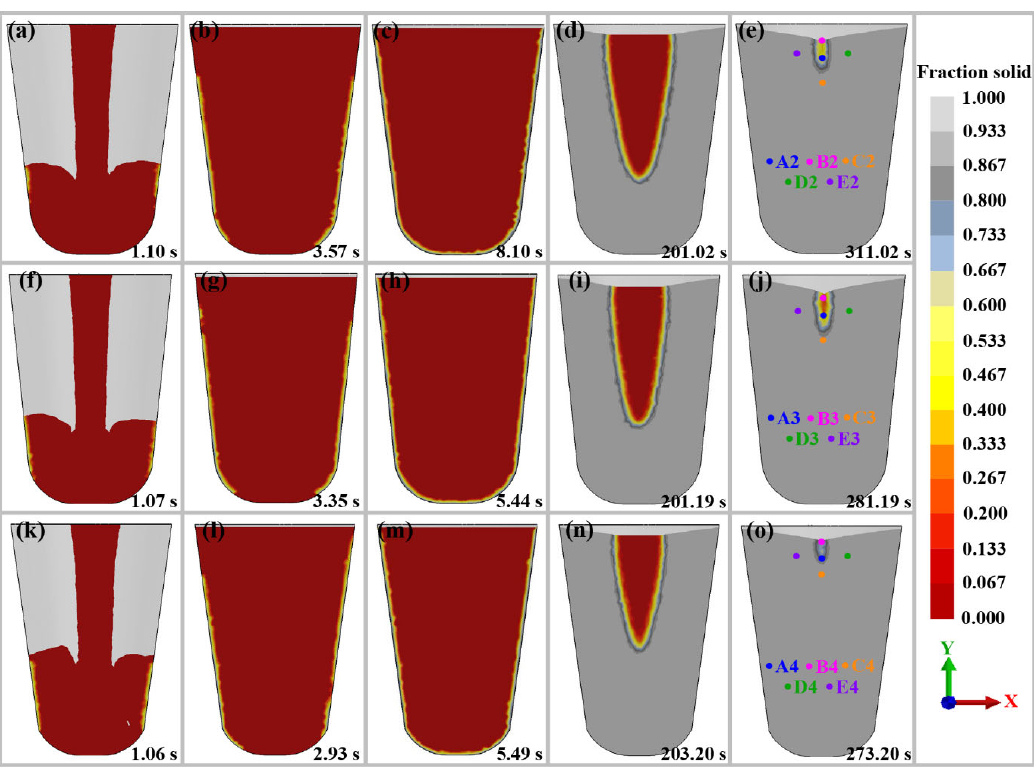
Metals 2022 , 12 , 2122 Figure 6. Solidification process of Ti ‐ 6Al ‐ 4V alloy in mold II ( a – e ), III ( f – j ), and IV ( k – o ). Figure 6. Solidification process of Ti-6Al-4V alloy in mold II ( a – e ), III ( f – j ), and IV ( k – o ).